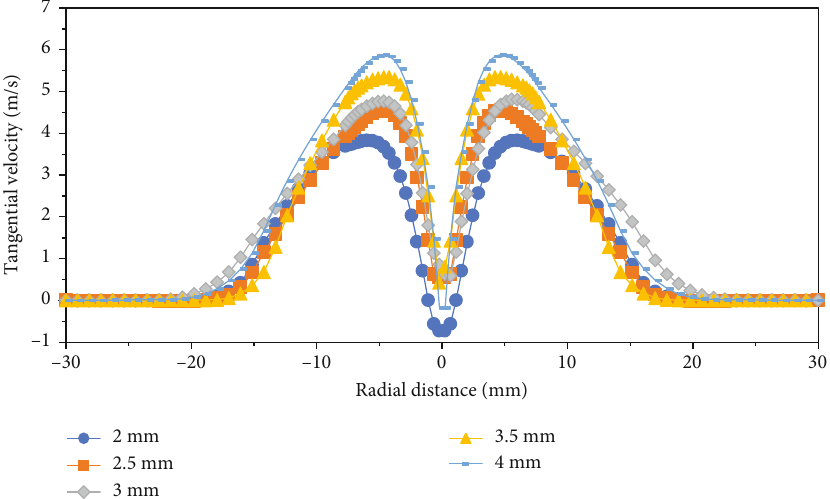
Figure 16: Tangential velocity distribution of di ff erent blade thicknesses in h / d = 8